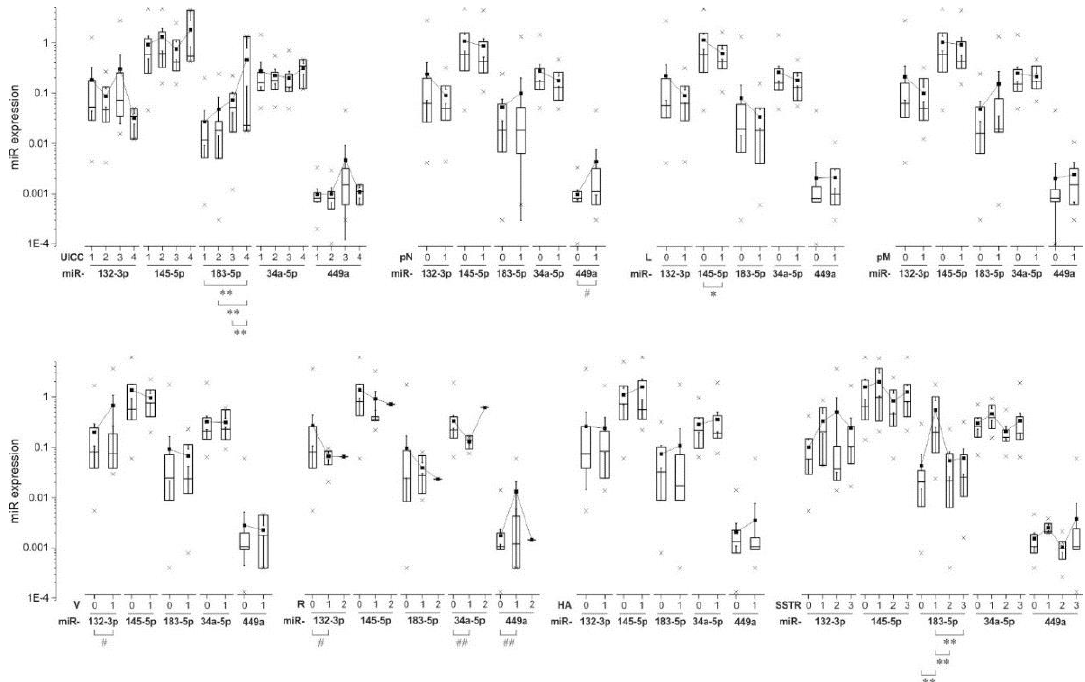
Figure 3. Relationship between miRNA expression and clinico-pathological data in pNET patients. Differences between expressions were tested using t -test or ANOVA and Bonferroni respectively. * p